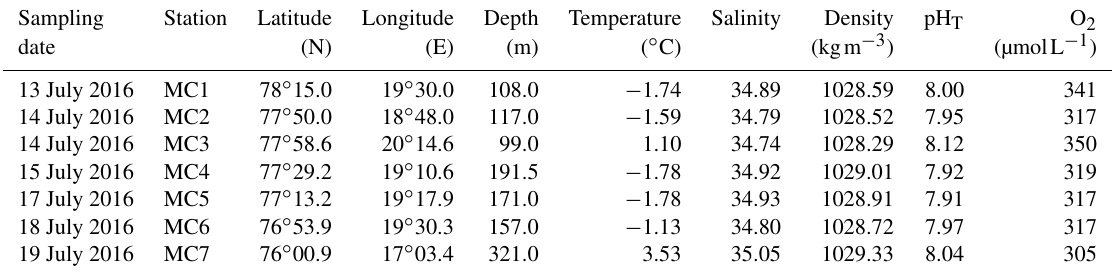
Table 1. Geographic coordinates, depths of the seven studied stations and bottom water parameters (temperature and salinity are measured in situ by the CTD, O 2 (dissolved oxygen) and pH T are measured from Niskin bottles). Sampling Station Latitude Longitude